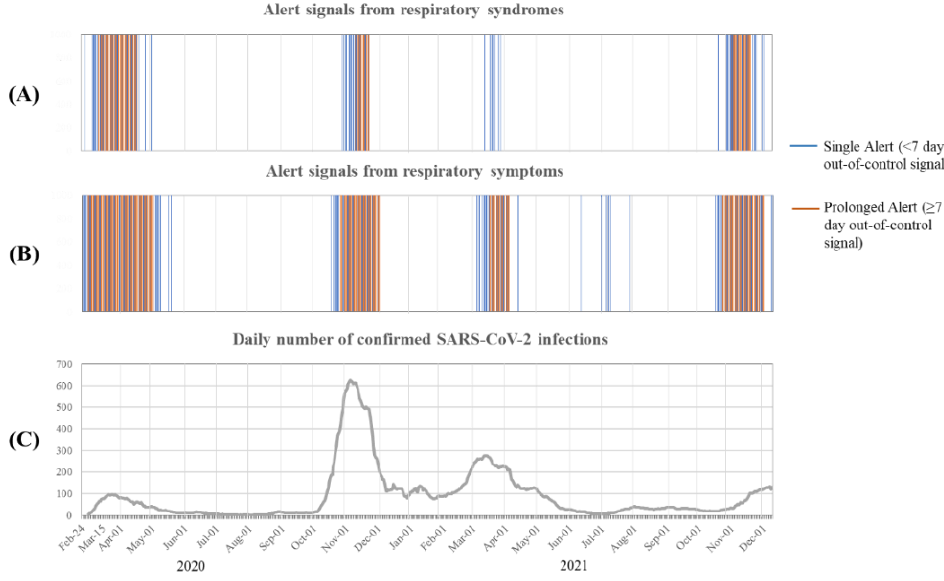
Figure 3. Comparing single and prolonged outlier daily signals generated from respiratory syn- dromes ( A ) and symptoms ( B ) and daily number of confirmed SARS-CoV-2 infections ( C ) during the period from 24 February 2020 to December 2021. Daily outlier signals were obtained by the Exponentially Weighted Moving Average control chart; colored vertical lines indicate days when the signal occurred; it was blue when only a single Alert (<7 day out-of-control signal) occurred, and red when the signal also regarded a prolonged Alert (≥7 day out-of-control signal). Seven-day mo- bile average was used for representing the daily number of confirmed SARS-CoV-2 infections.